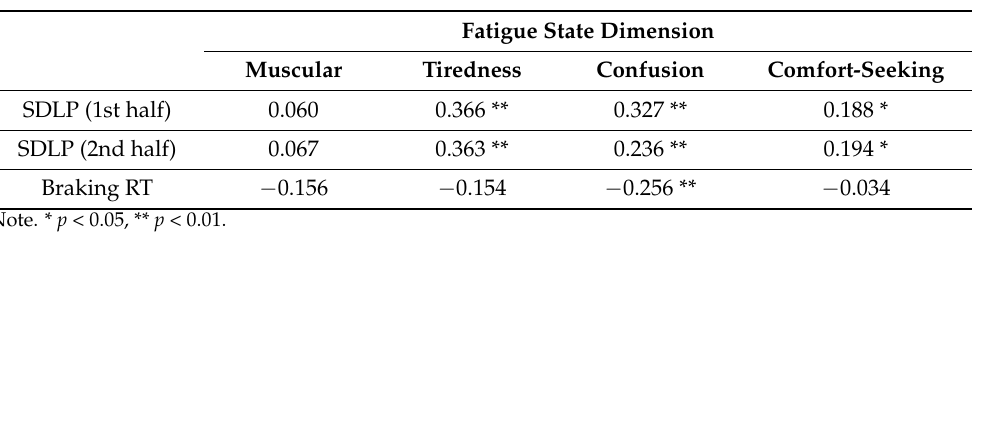
Table 6. Correlations between four fatigue state dimensions and performance measures.